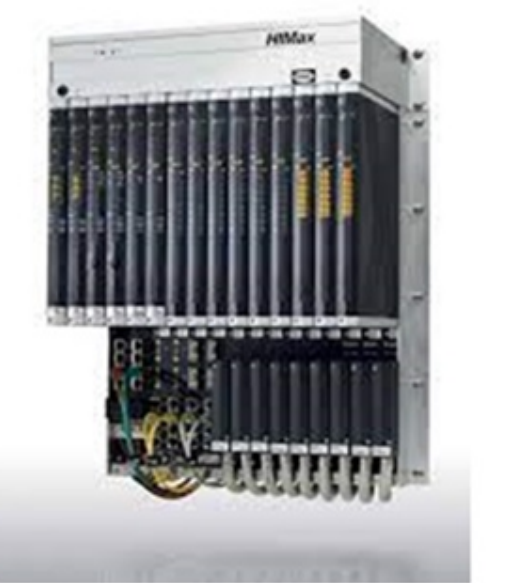
Figure 5. An example HIMatrix controller HW that can be used for IZZ